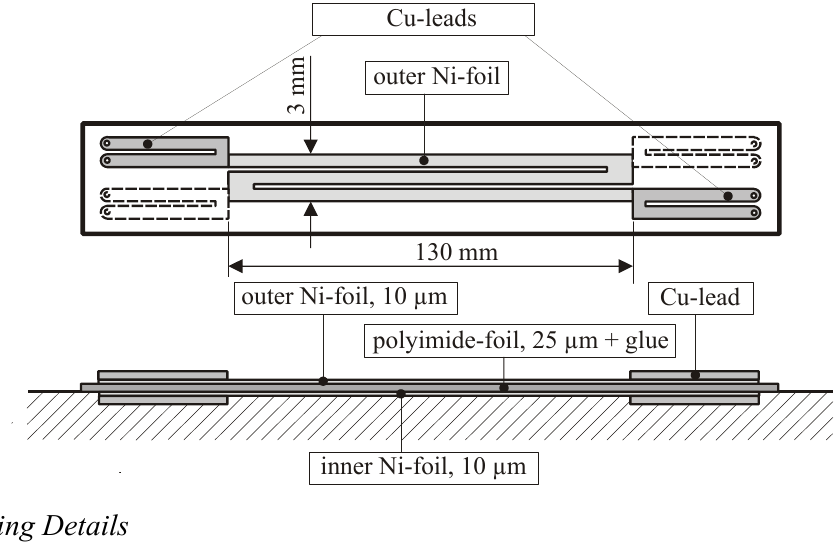
Figure 4. Simple sensor geometry for measurements in two-dimensional flows; the broken lines in the upper picture are the Cu-leads of the hidden Ni-foil underneath the polyimide